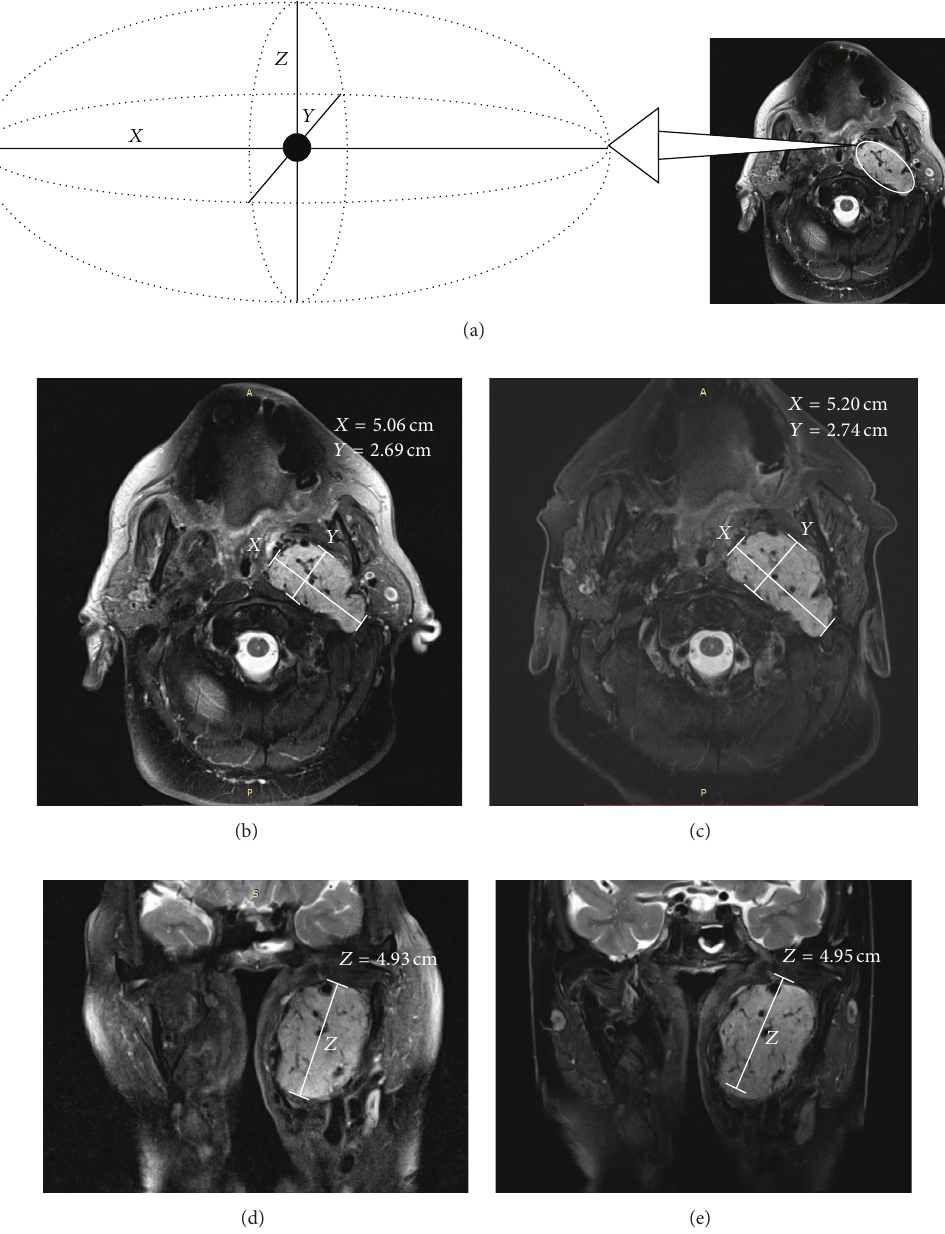
Figure 1: (a) The untreated left glomus vagale was considered to have an ellipsoid shape. The 3 perpendicular dimensions in the anteroposterior ( 𝑋 ), mediolateral ( 𝑌 ), and craniocaudal ( 𝑍 ) directions were used to calculate the maximum axial area and volume. ((b)– (e)) Serial MRI scans ( 𝑇 2 fat saturation suppressed sequence) on axial slice performed in 2012 (b) and 15 months later (c), and on coronal slice performed in 2012 (d) and 15 months later (e), have demonstrated minimal change in tumor size over time. The maximum axial dimension was taken as 𝑋 , which is the larger of the two dimensions on axial slice ( 𝑋 and 𝑌